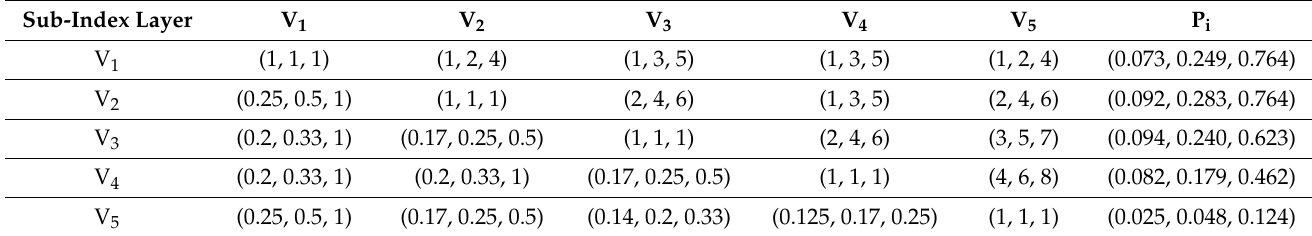
Table 7. Vulnerability layer weights determined by